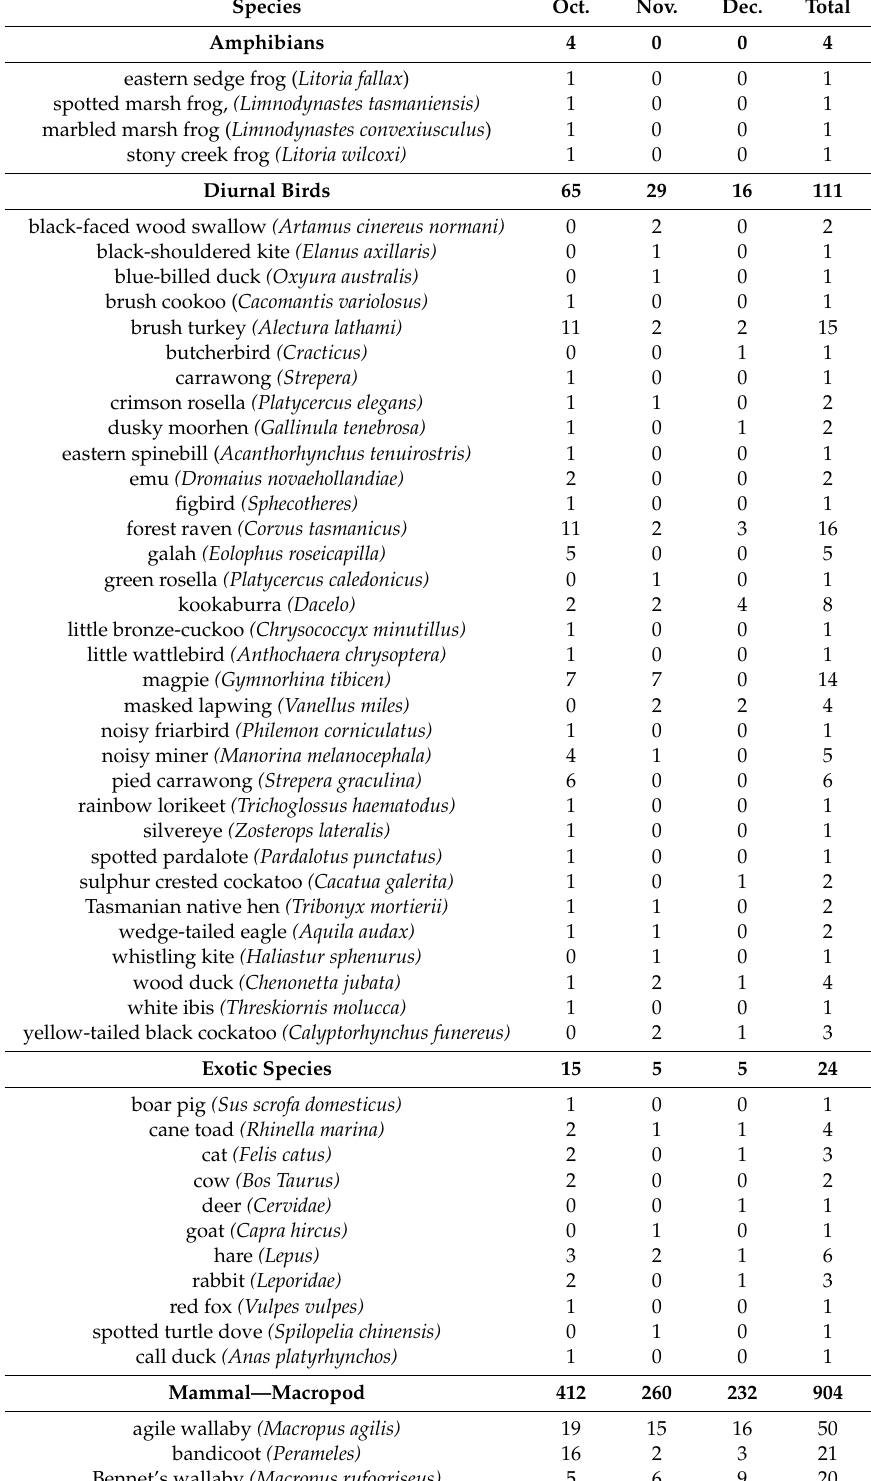
Table A2. Animal roadkill recorded by the RRApp categorised by group and